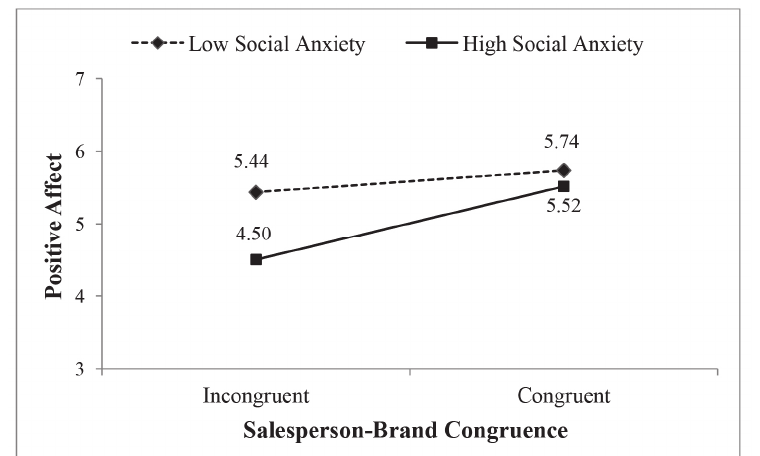
<Figure 5> The Moderating Effect of Social Anxiety on Relationship between Salesperson-Brand Congruence and Positive Affect (Study 2,